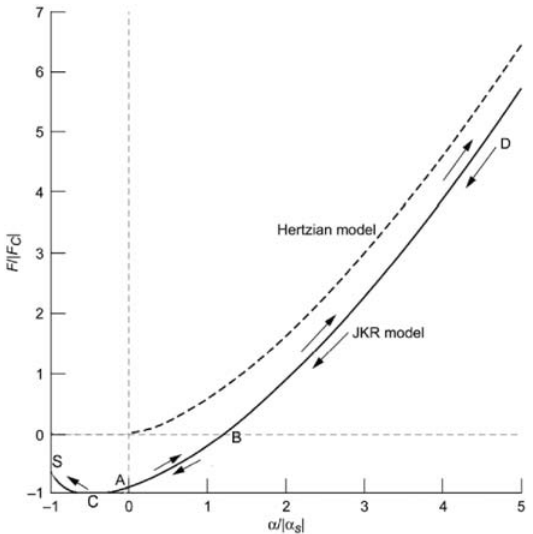
Fig. 1 Force-displacement curves for the cohesive JKR model and for a non-cohesive linear elastic Hertzian contact between two spheres. F c is the cohesive pull-off force and α s is the (outward) elastic dis- placement at final separation [Mei,